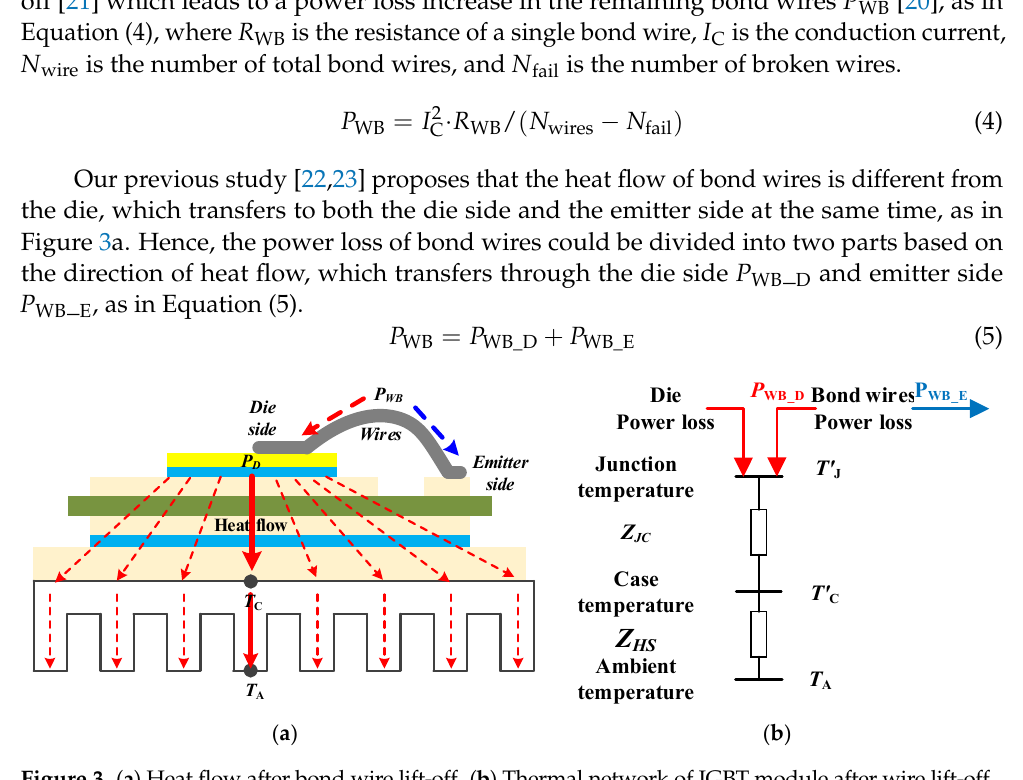
However, the total resistance of parallel bond wires increases after bond wire lift-off [21] which leads to a power loss increase in the remaining bond wires P WB [20], as in Equa- tion (4), where R WB is the resistance of a single bond wire, I C is the conduction current, N wire is the number of total bond wires, and N fail is the number of broken wires.